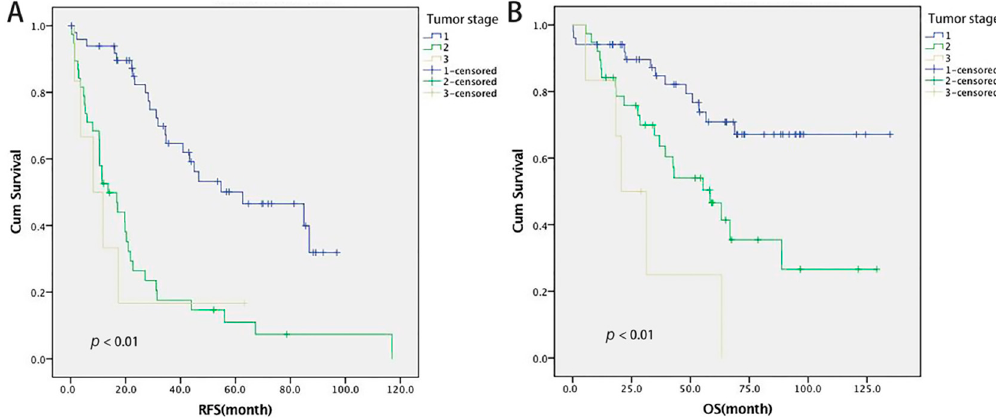
Figure 1. The RFS and OS curves for different HCC stage in the HS group ( A : RFS; B : OS). The median RFS during the whole follow-up in the HSS and HA group was 38.2 and 32.3 months ( p > 0.05), with OS 59.4 and 54 months ( p > 0.05), respectively. The RFS rates at 1, 2, 3, and 5 years in the HSS and HA groups were 95% and 81% ( p = 0.041), 81% and 67% ( p = 0.05), 64% and 62% ( p = 1.00), 29% and 45% ( p = 0.10) (Figure 2). The OS rates at 1, 3, and 5 years in the HSS and HA group were 98% and 98% ( p = 1.00), 79% and 88% ( p = 0.50), and 60% and 64% ( p = 0.61), respectively. The OS rate during the whole follow-up was 79% and 64% in the HSS and HA group ( p = 0.181), respectively (Figure 3).